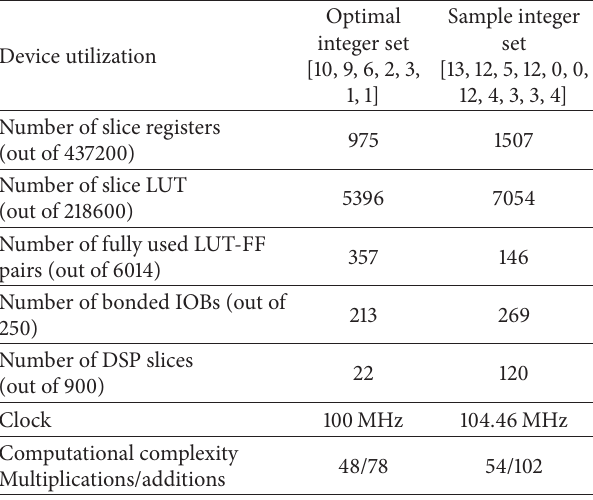
Table 3: Device utilization